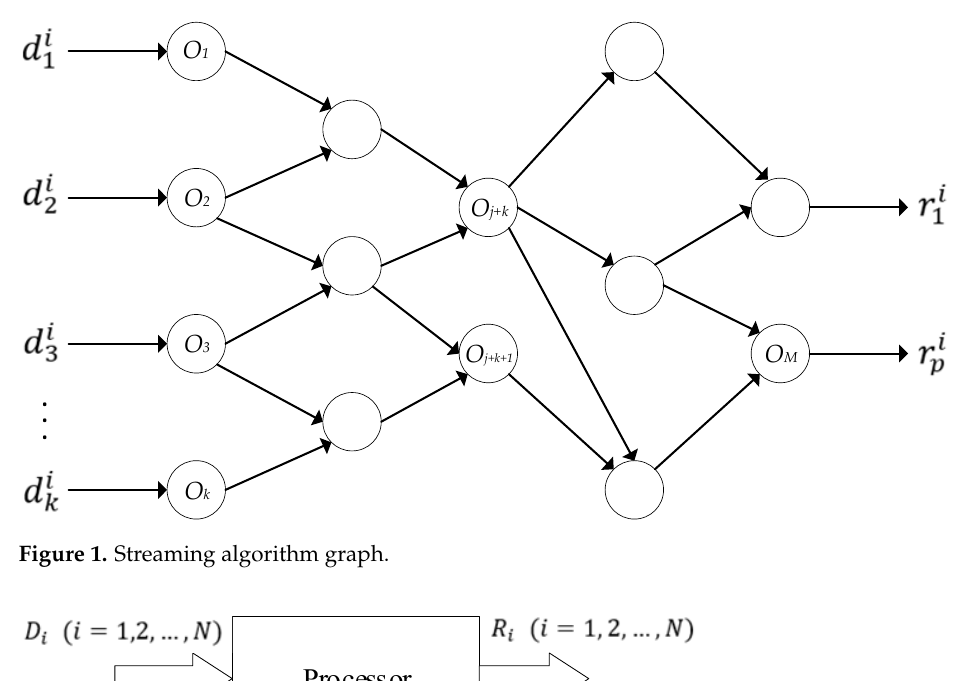
Figure 2. Operations in typical computer with von Neumann architecture.